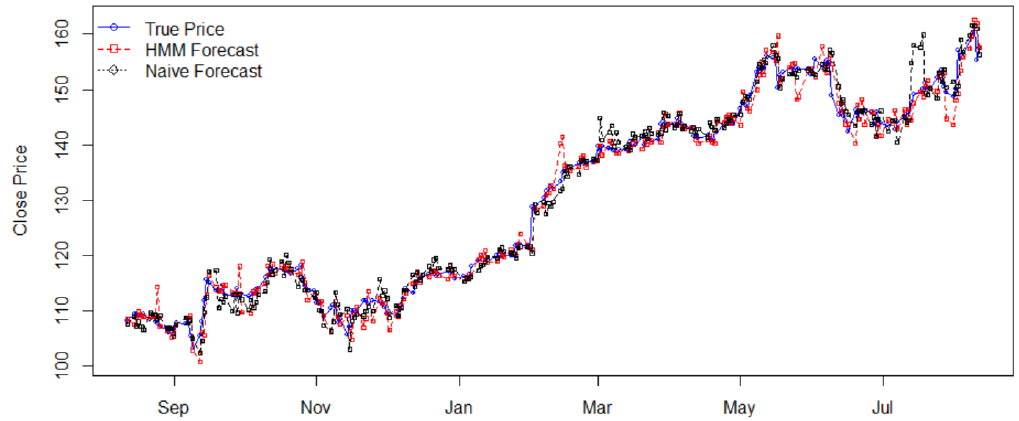
Figure 6. HMM prediction of Apple stock daily close prices from 15 August 2016 to 11 August 2017 using two-states HMM and the naïve model.